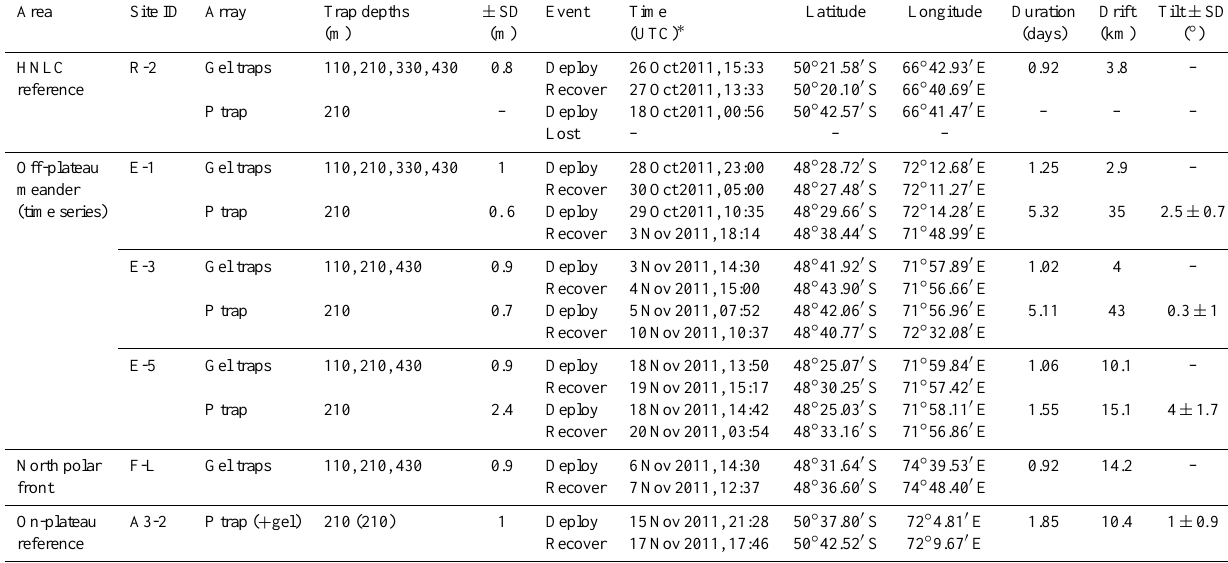
Table 1. Deployment schedules for free-drifting sediment trap arrays.